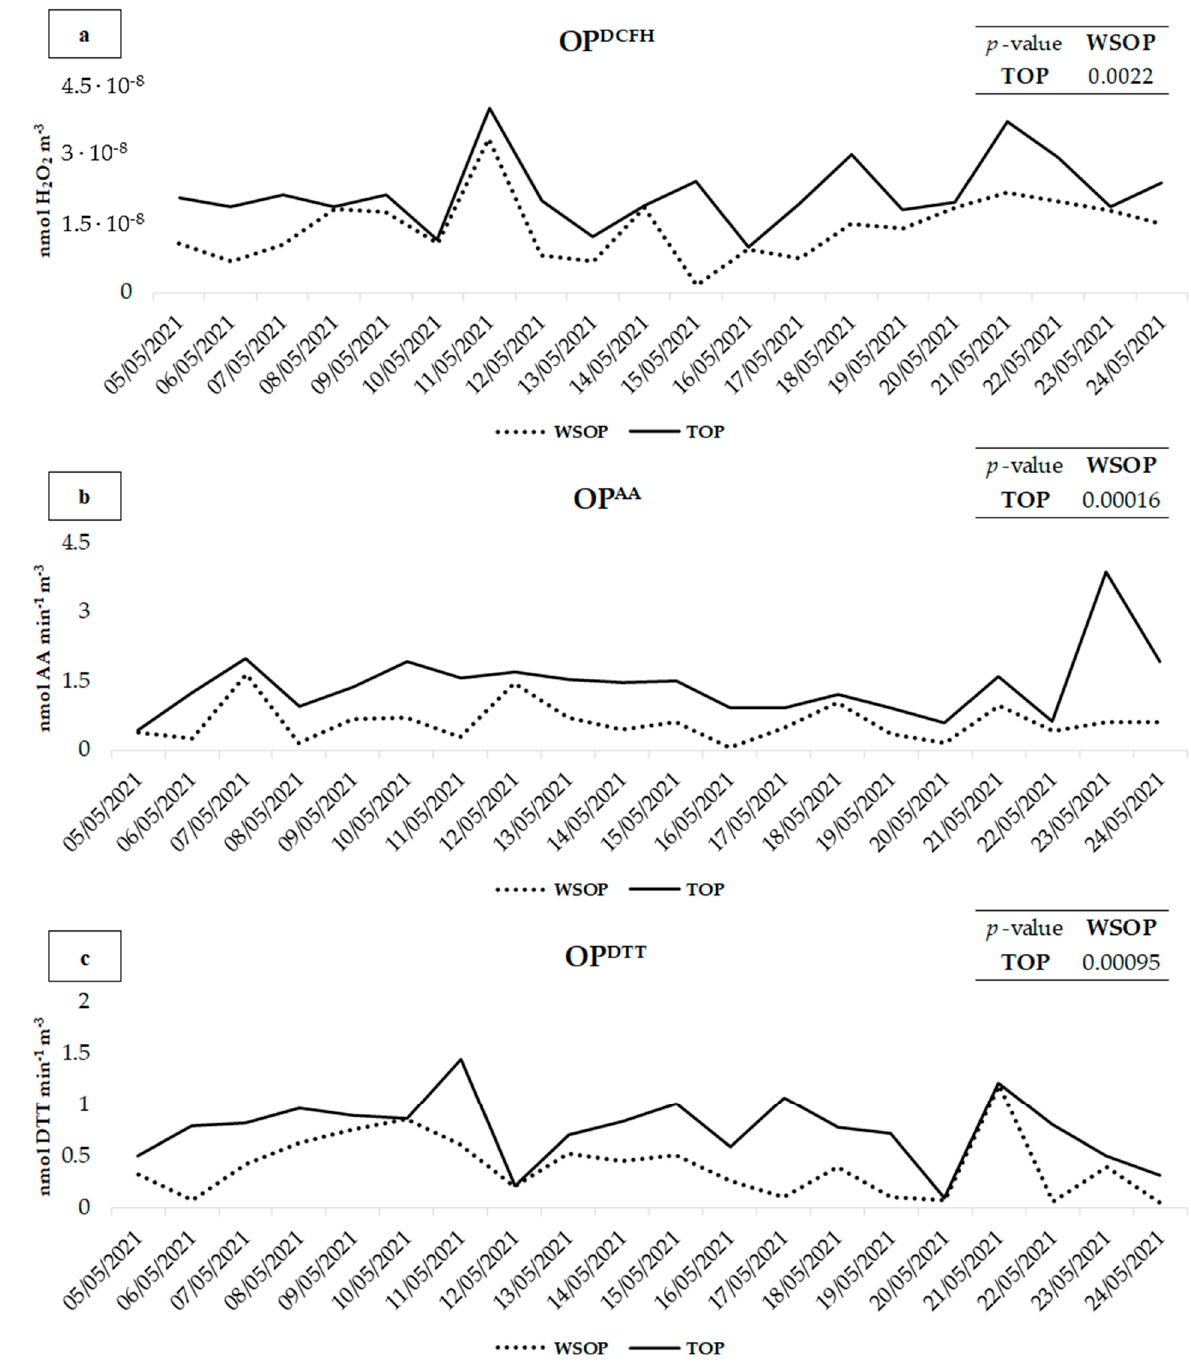
Figure 2. Comparison of OP AA ( a ), OP DTT ( b ), and OP DCFH ( c ) values between the TOP and WSOP of PM 10 samples collected at PR.